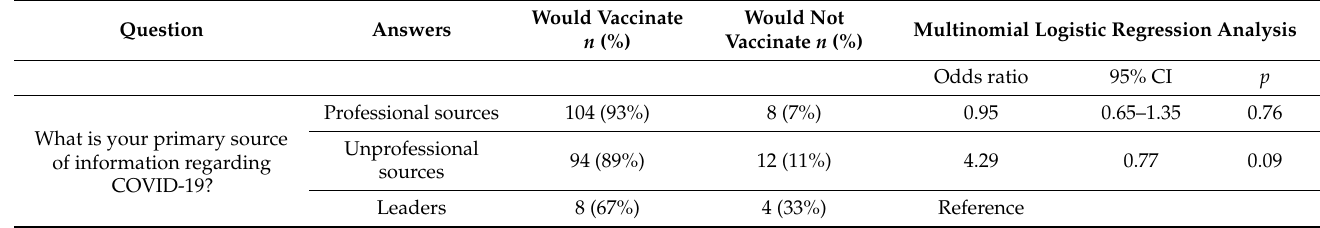
Table 3. Relationship between factors and determinants influencing acceptance and willingness to